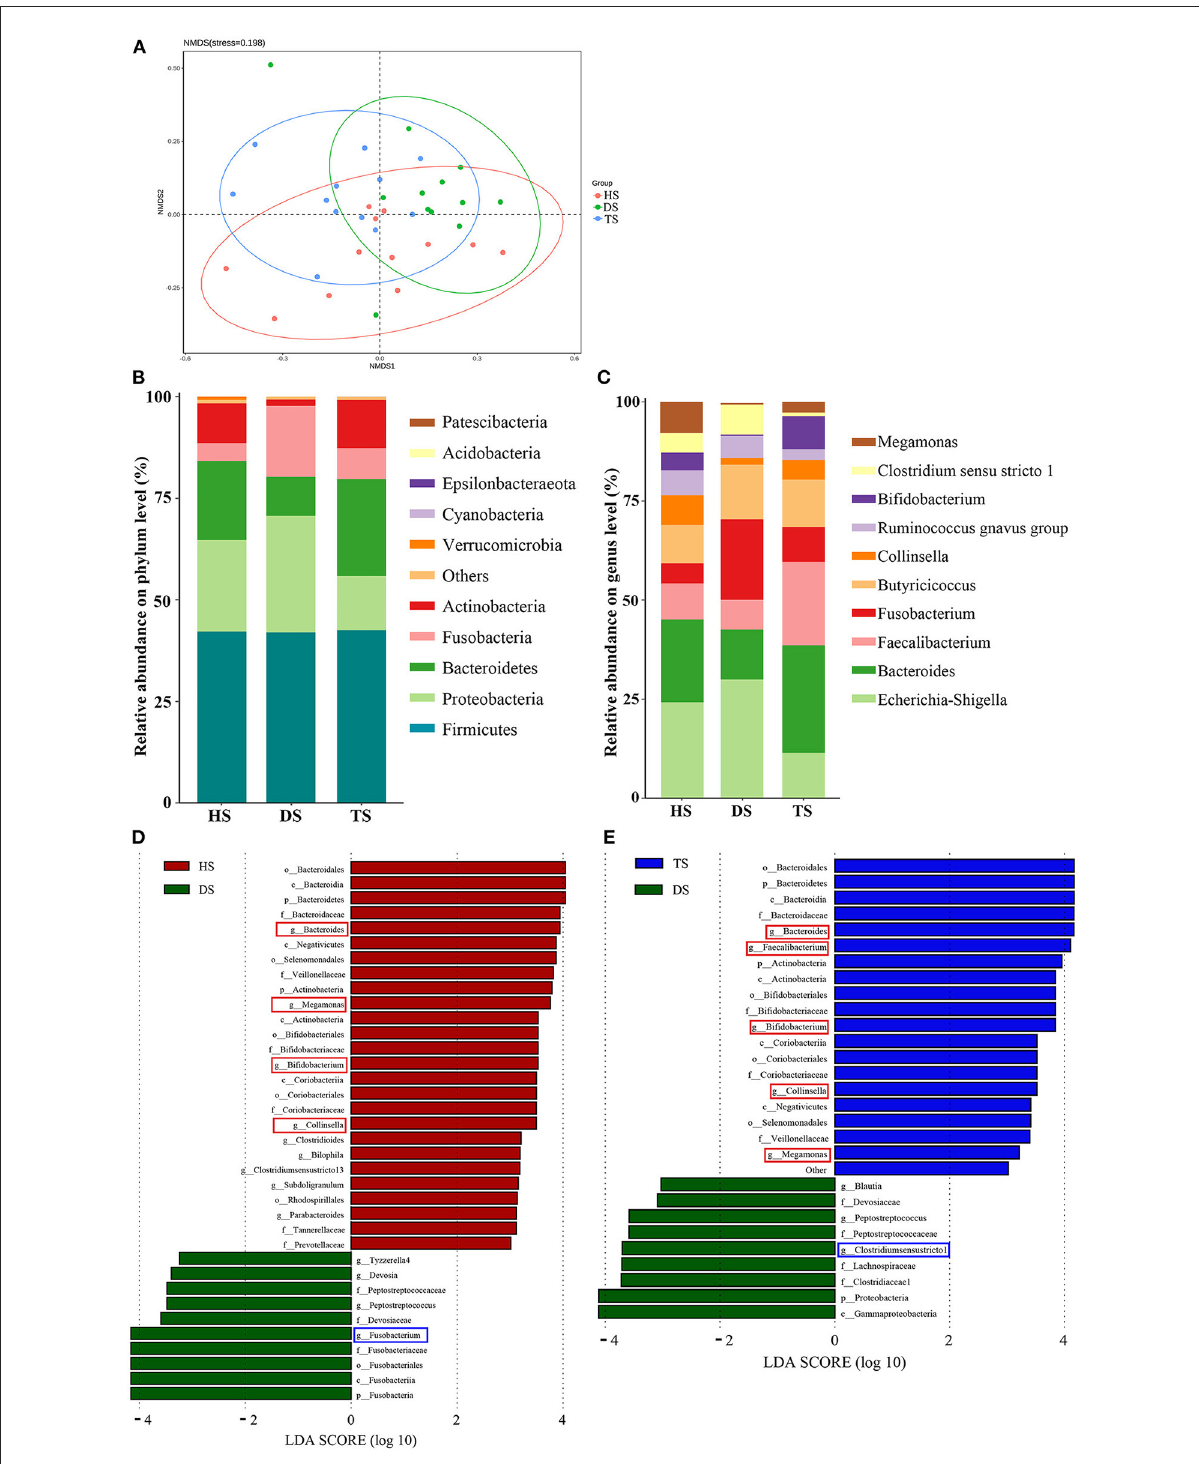
FIGURE3 Comparison of the fecal-microbiota structures and distributions in different groups. (A) Plots of non-metric multidimensional scaling (NMDS) of 3 groups; (B, C) Relative abundance of the fecal microbiota at the phylum and genus level; (D, E) Linear discriminant analysis (LDA) among different groups from the linear discriminant analysis. The linear discriminant analysis effect size method identifies the most differentially abundant bacterial taxa, but only taxa meeting an LDA significance threshold of > 3.0 are shown. HS, healthy calf fecal sample; DS, diarrheal calf fecal sample; TS, PLP treatment diarrheal calf fecal sample; PLP, Pueraria lobata